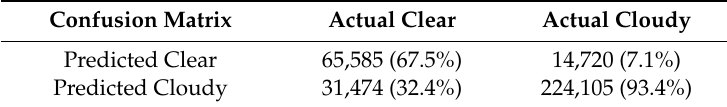
Table 1. Confusion matrix for optimal RF configuration on the independent test dataset.